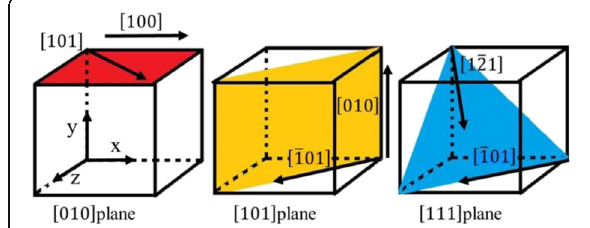
Fig. 2 Schematic diagram of cutting directions on the crystal planes of monocrystalline germanium